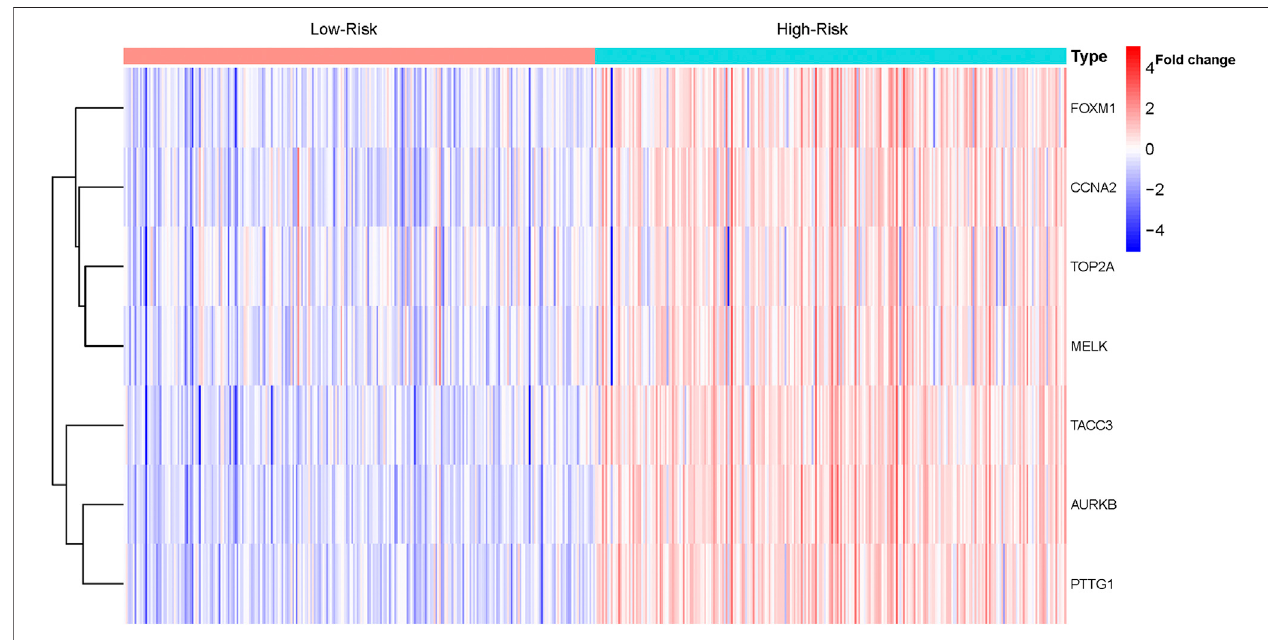
FIGURE 7 | Heatmap of the expression of the seven genes in